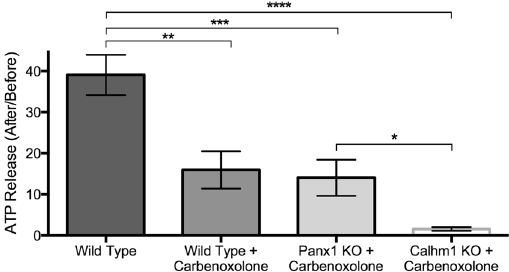
Figure 2. Apical ATP release 15 seconds after a 55-mmHg air puff in nasal septal epithelial cell cultures from wild-type (control) mice, and Calhm1 knockout, Panx1 knockout, and wild-type mice preincubated with 150 μ M carbenoxolone. Bars are means ± SE of 5–6 cultures each. * p < 0.05, ** p < 0.01, *** p < 0.001, **** p < 0.0001, ANOVA with Holm Sidak’s multiple comparisons test.